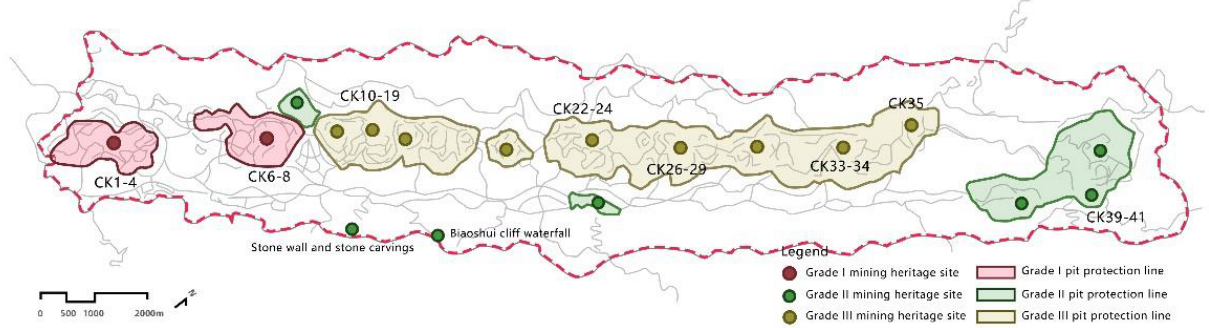
Figure 1. Protection and utilization planning of mining relics in Tongluo Mountain Mine Park.